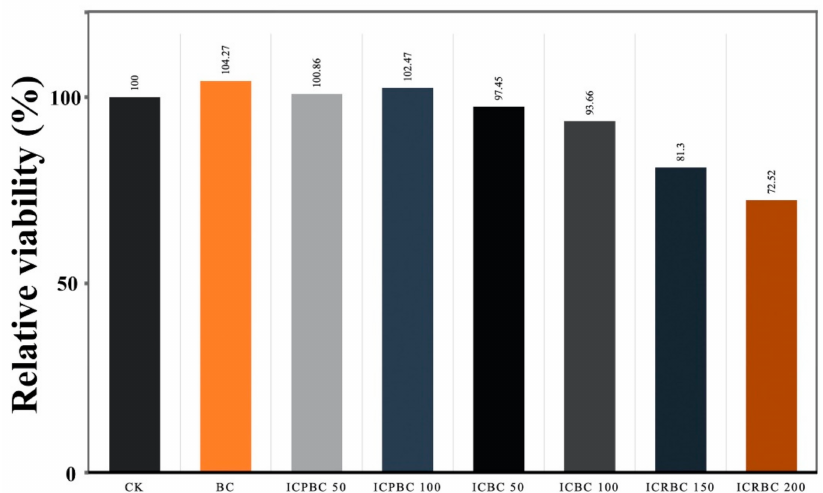
Figure 9. In vitro cytotoxicity results; Cell viability when contacting with membrane